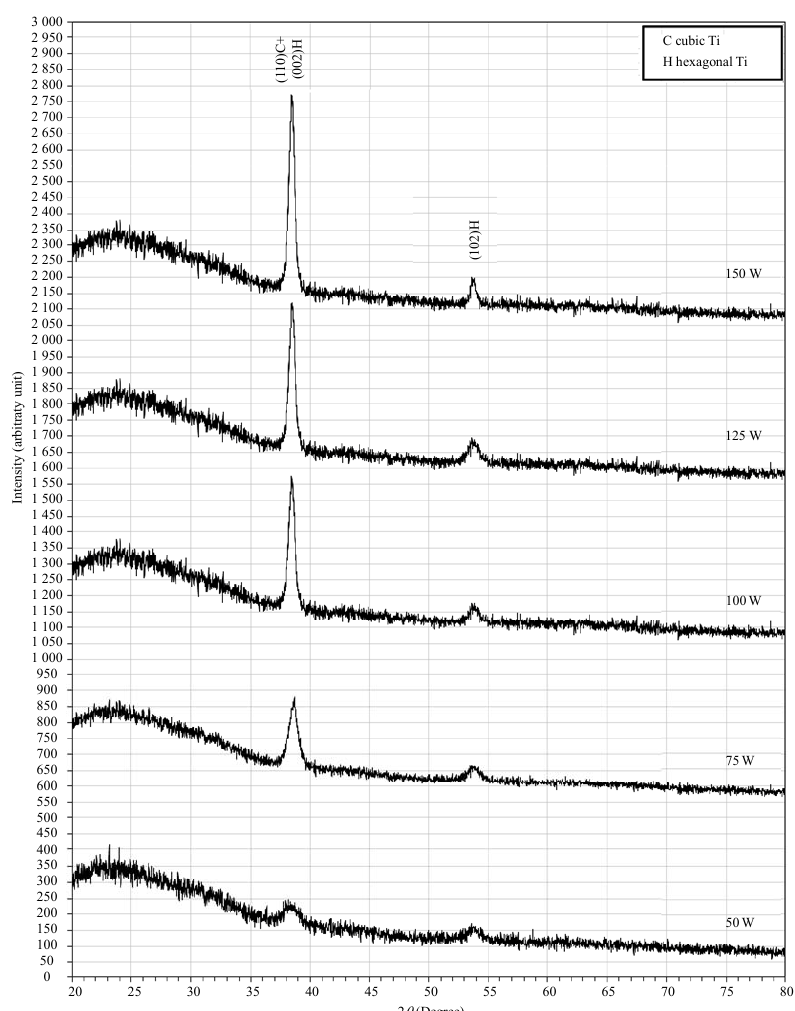
Fig. 1 X-ray diffraction patterns of the (Ti6A14V) films deposited on the glass substrate at different sputtering